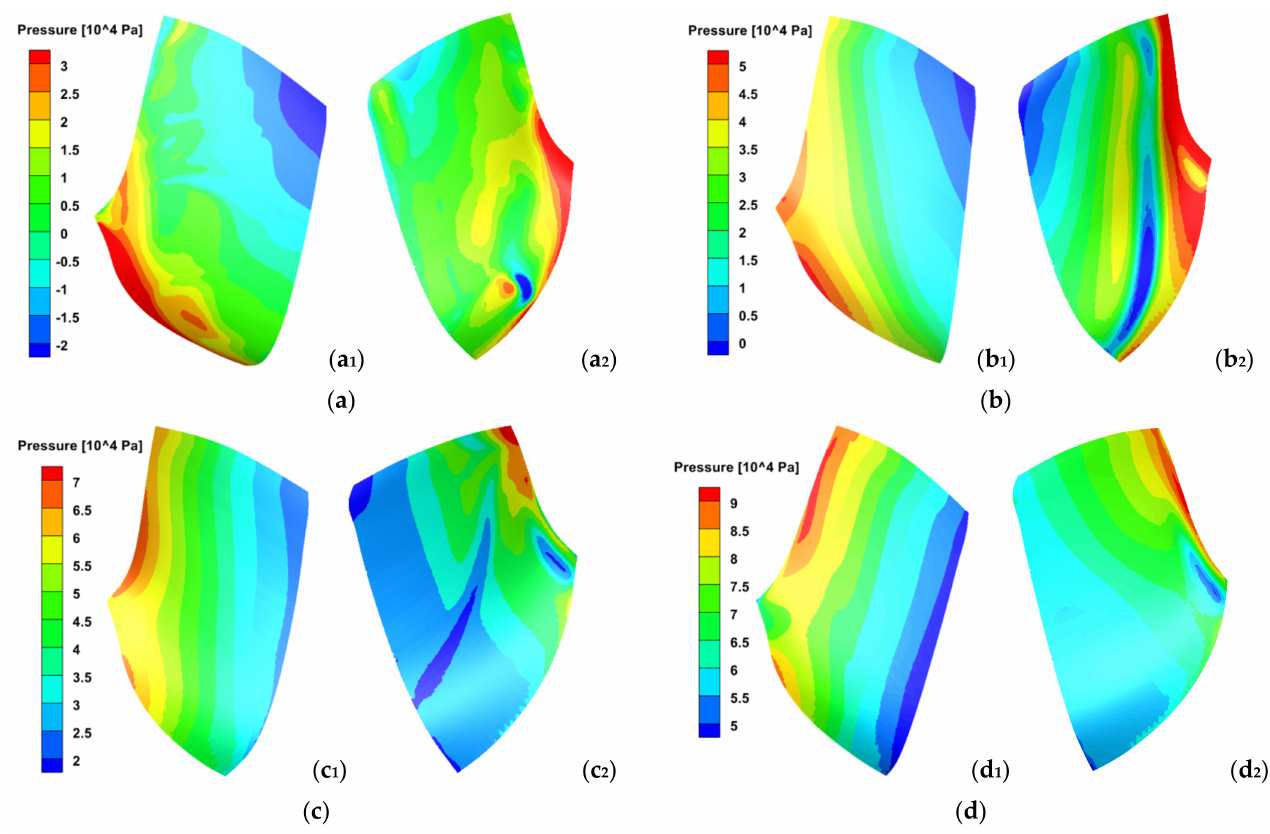
Figure 11. Blade contour plot at runner. ( a ) α = 13.50 mm (small opening condition): ( a 1 ) Upstream surface (Pa), ( a 2 ) Back surface (Pa); ( b ) α = 26.17 mm: ( b 1 ) Upstream surface (Pa), ( b 2 ) Back surface (Pa); ( c ) α = 38.05 mm: ( c 1 ) Upstream surface (Pa), ( c 2 ) Back surface (Pa); ( d ) α = 48.74 mm (optimal condition): ( d 1 ) Upstream surface (Pa), ( d 2 ) Back surface